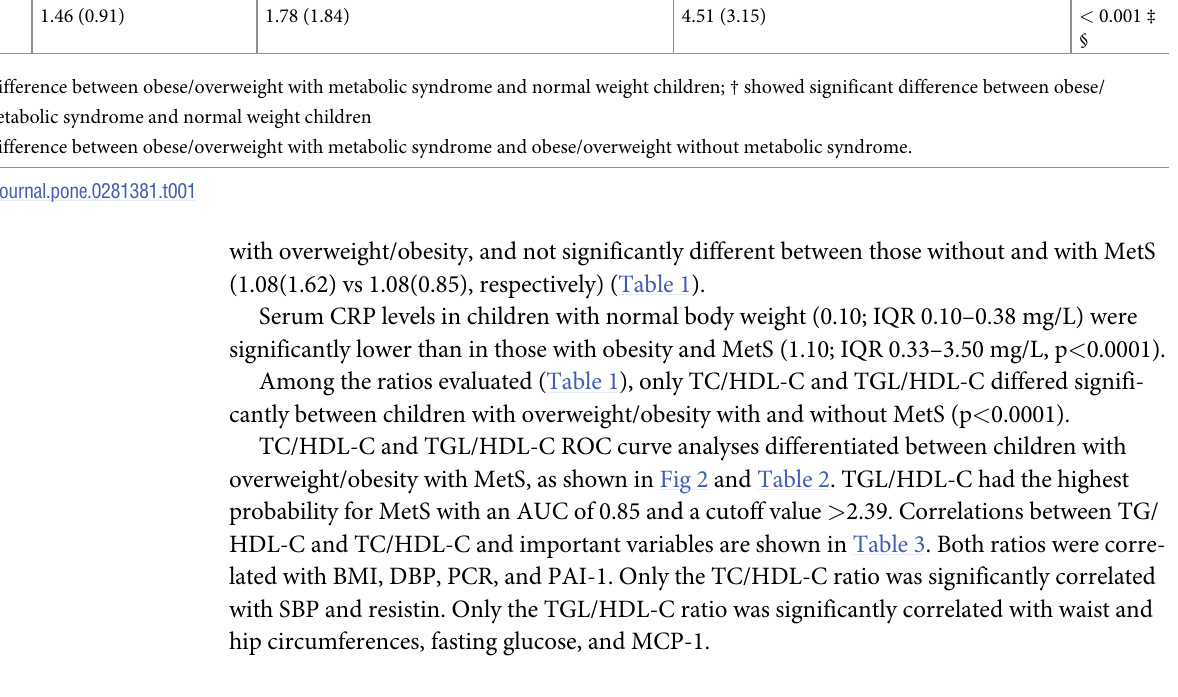
PLOS ONE | https://doi.org/10.1371/journal.pone.0281381 March 15,